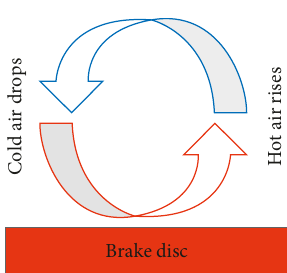
Figure 4: Convective heat transfer between surface of the brake and air.